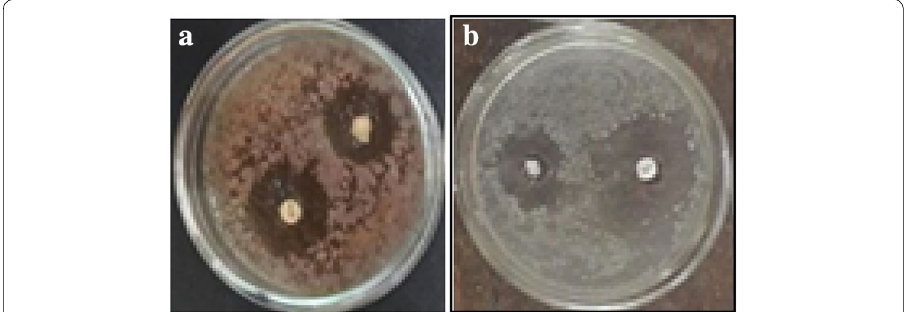
Fig. 6 Images for zone of inhibition of fabric treated with curcumin nanoemulsion and erythromycin stand- ard antibiotic strip against a B. subtilis (Gram positive bacteria) and b E. coli (Gram negative